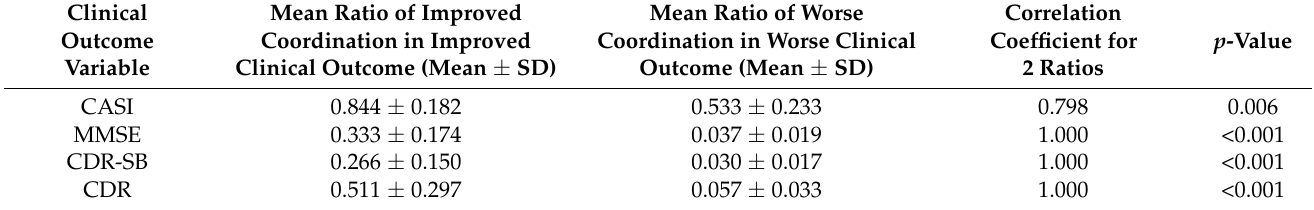
Table 4. Association between coordination function and various clinical outcome measurements in the lower